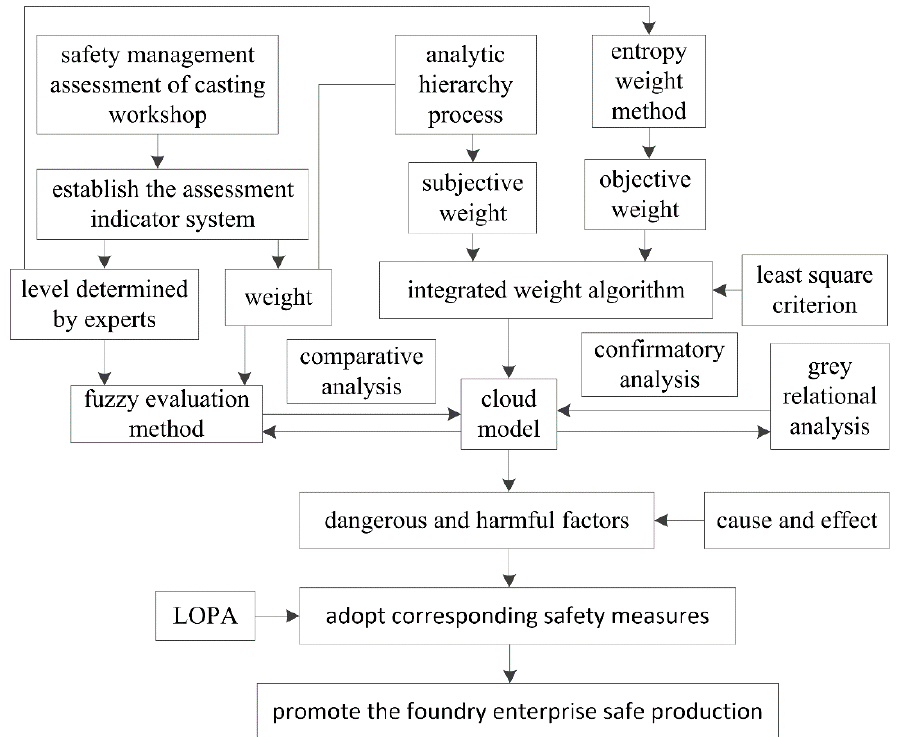
Figure 1. Framework of the proposed safety assessment method.